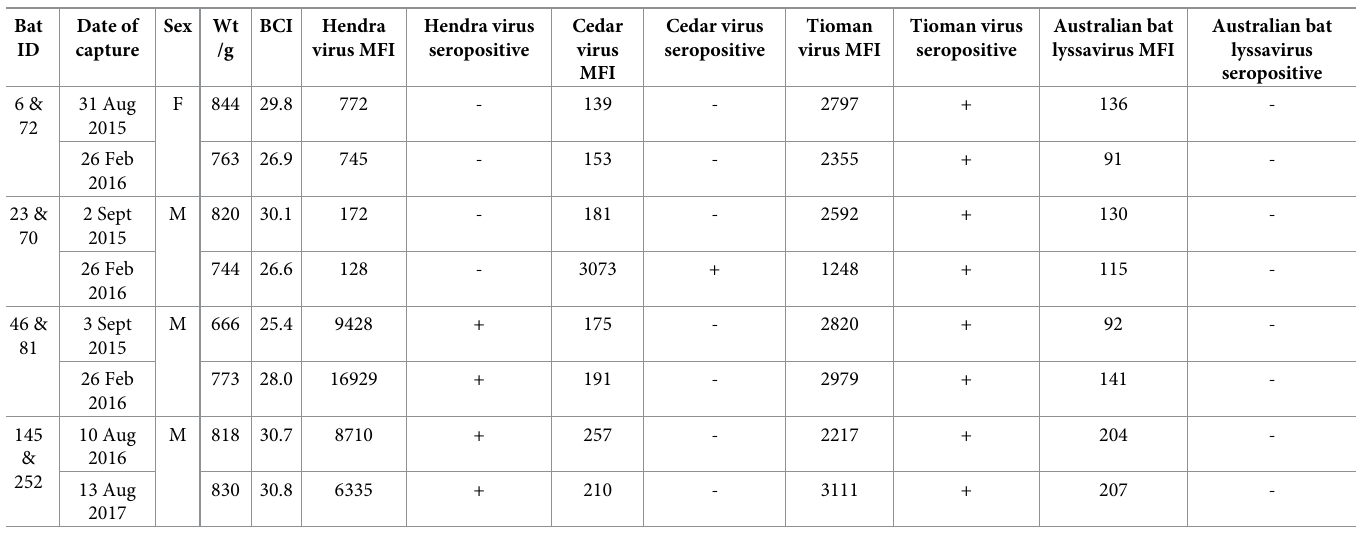
Table 6. Seroprevalence changes in recaptured Grey-headed flying foxes.